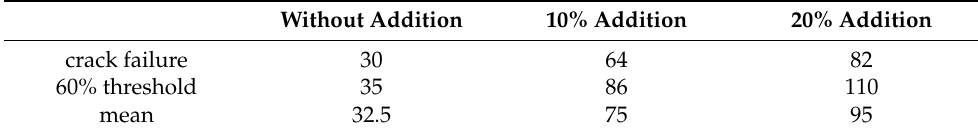
Table 3. Number of cycles before failure occurs. Without Addition